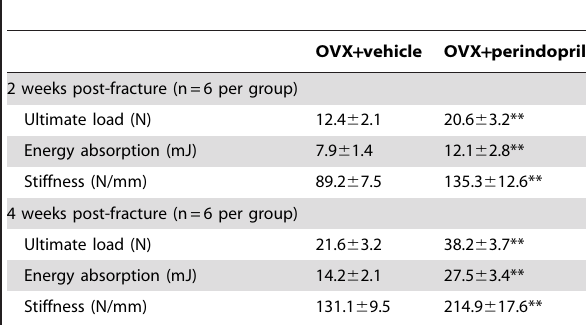
Table 1. Biomechanical parameters in the fractured site of